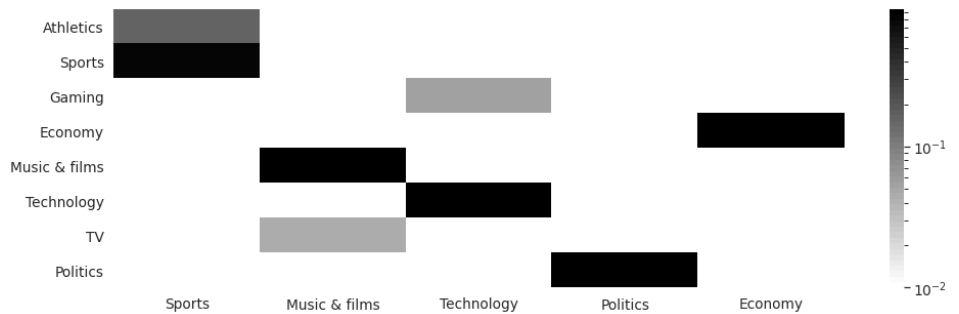
Figure 2. Heat map showing how topic terms of the 5 γ = 0.8 topics (columns) get distributed on 8 topics at γ = 1.0 (rows).